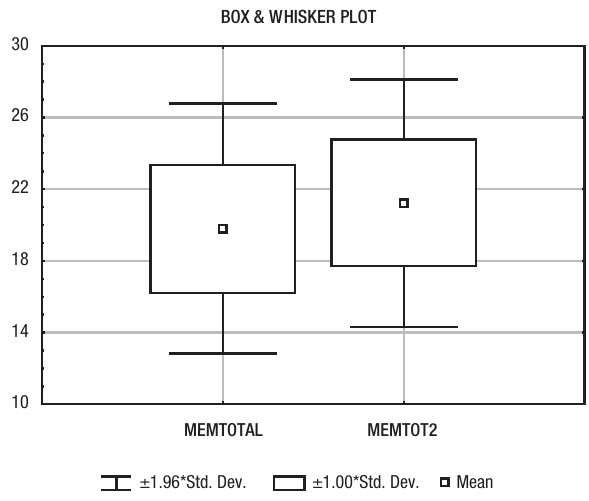
Figure 2. Means on MMSE. MEMTOTAL, MSDR sample; MEMTOT2, sample of HSM.